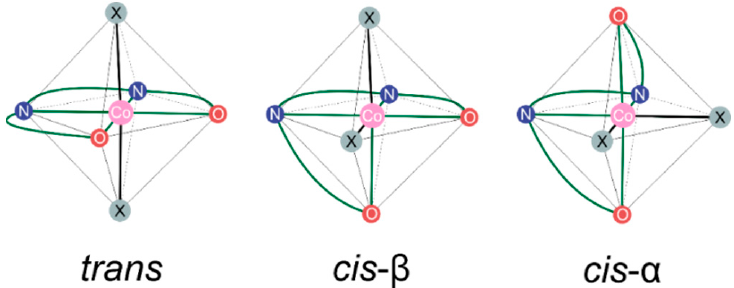
Figure 2. Idealized possible arrangements of salen ‐ type ligand in the octahedral organometallic Co(III) complexes with schematically depicted position of N 2 O 2 Schiff base donor atoms. Two va ‐ cant positions, available for other additional ligand or ligands (if any), are marked by X.